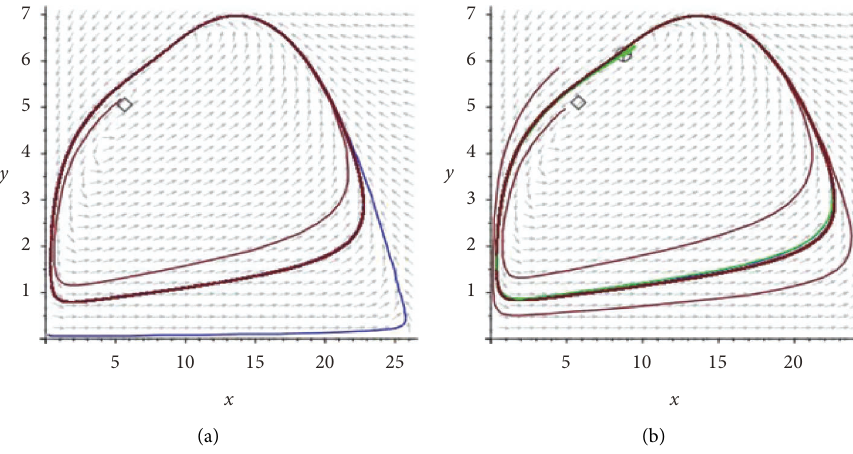
Figure 10: Phase diagrams in cases (ii) and (viii).